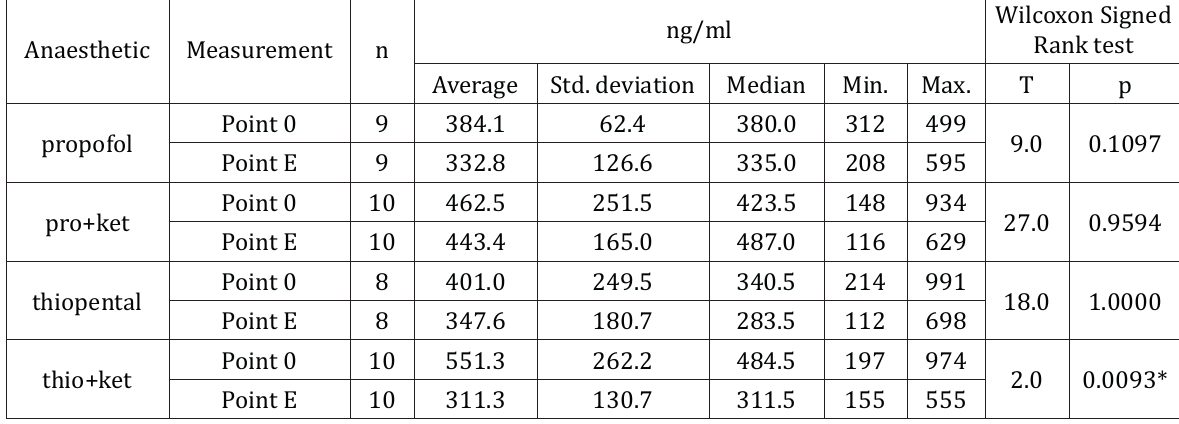
Table 6. Descriptive statistics - Concentration of MMP-9 in patients treated using different anaesthetics at two points in time and the results of a Wilcoxon Signed Rank test